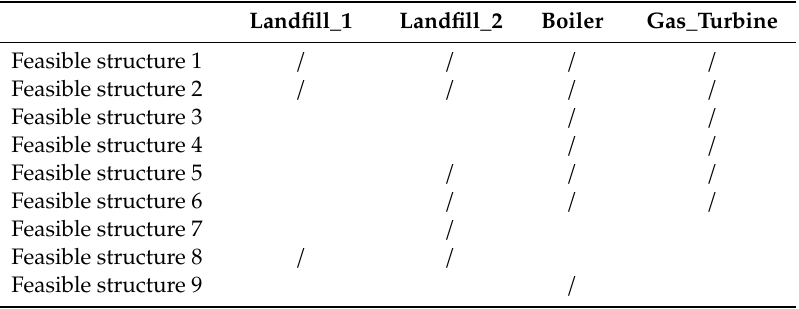
Table 7. Operating units that a ff ected the volume of GHG emissions.